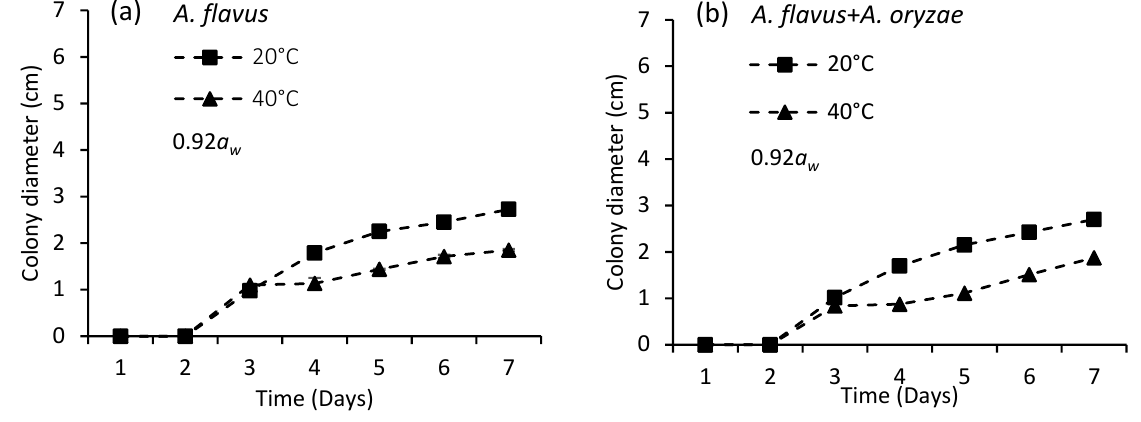
Figure 2. Growth of A. flavus in ( a ) single and ( b ) dual cultures with A. oryzae incubated under static temperatures of 20 °C and 40 °C for 7 days at 0.92 a w on chili-based agar.